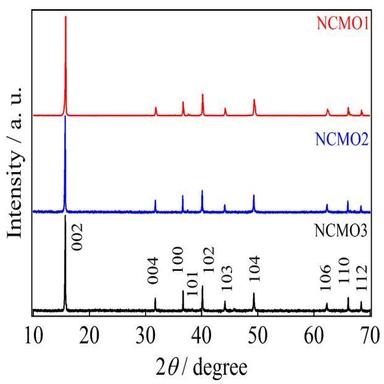
X-ray diffraction patterns of NCMO1, NCMO2, and NCMO3.